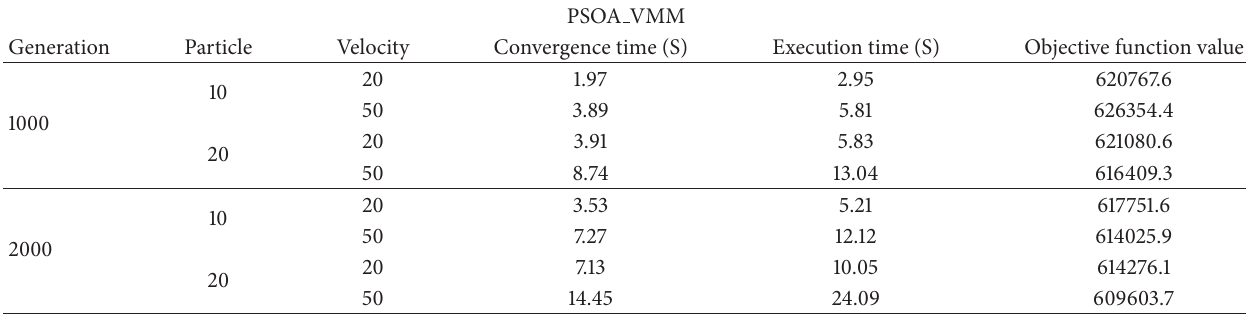
Table 5: Experimental design results of PSOA VMM with different groups of parameters.